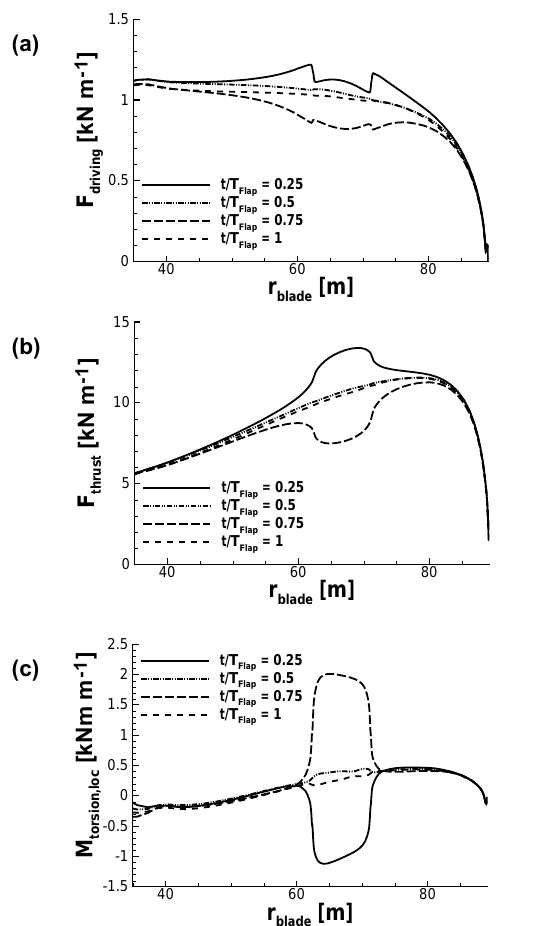
Figure 13. 6p sectional forces (driving force, a ; thrust, b ; and local torsion moment, c